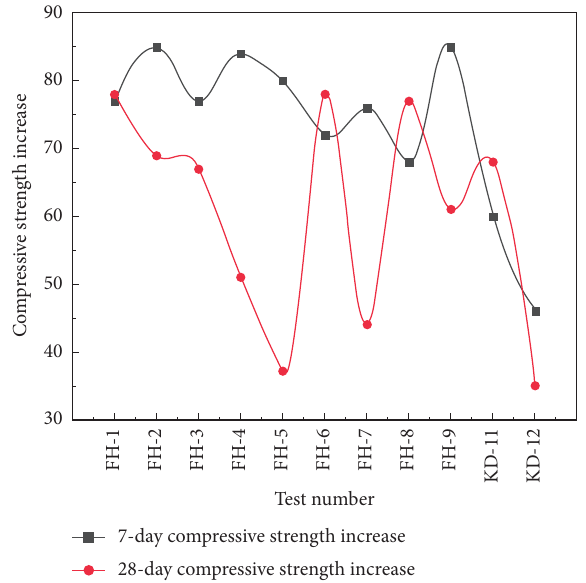
Figure 3: Increase of compressive strength with curing